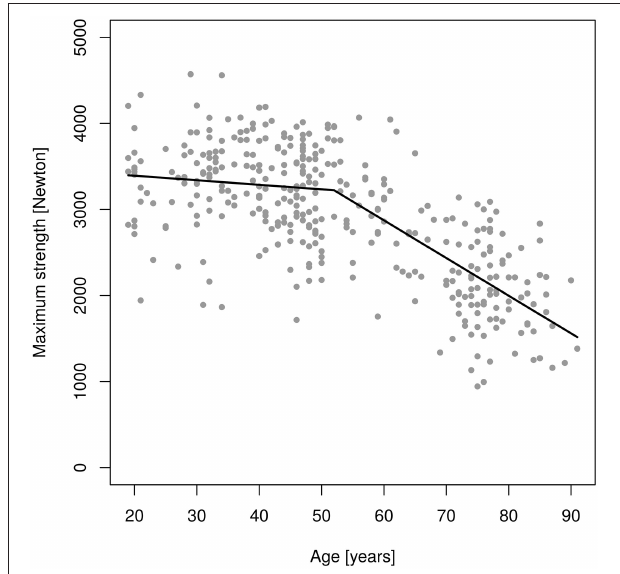
FIGURE 2 | Changes of maximum isokinetic hip/leg extensor strength (MIES) during adulthood as determined by an isokinetic leg-press.